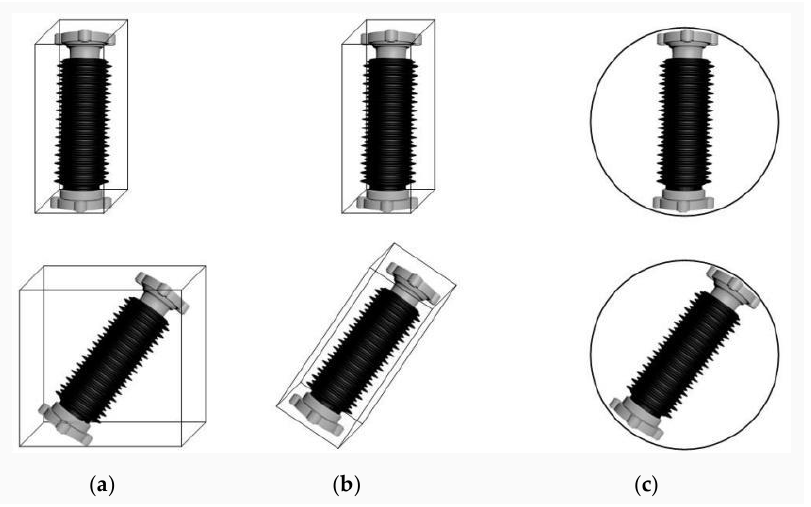
Figure 2. The bounding boxes of the objects. ( a ) AABB bounding box; ( b ) OBB bounding box; ( c ) bounding sphere.